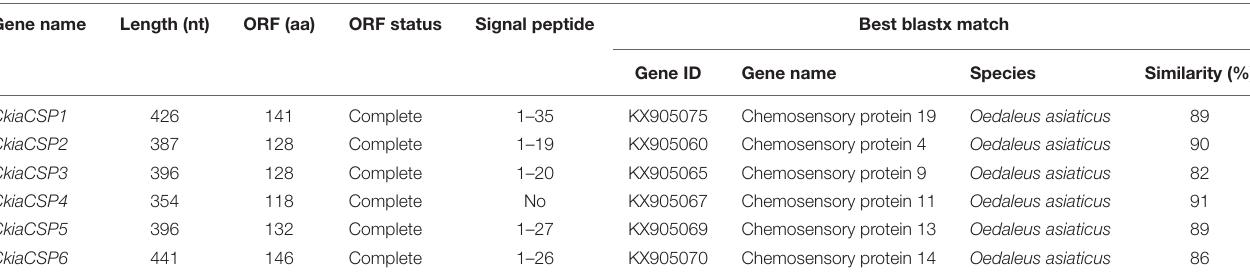
FIGURE 4 | Phylogenetic tree of putative odorant-binding proteins (OBPs) from C. kiangsu and other insects. Branch support (circles at the branch nodes) was estimated using bootstrap values based on the scale indicated on the top right. TABLE 4 | Summary of putative chemosensory proteins (CSPs) identified in C. kiangsu